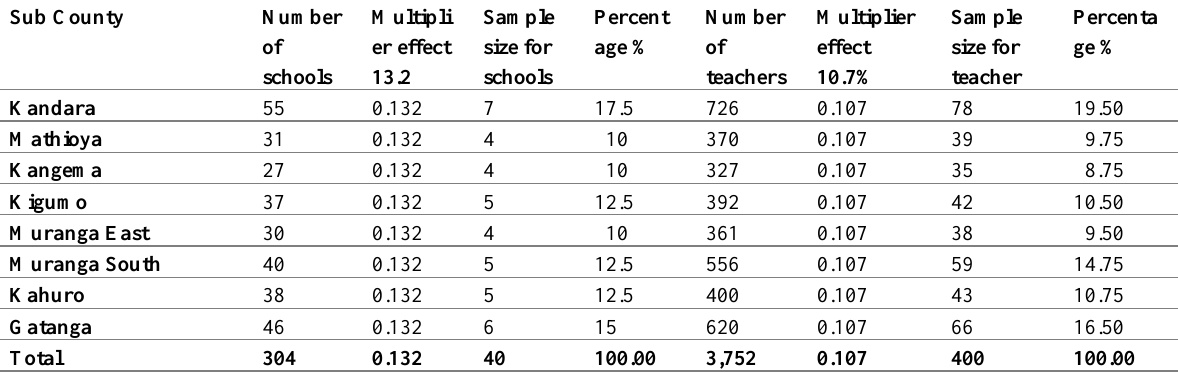
Table 1: Distribution of Sample Size